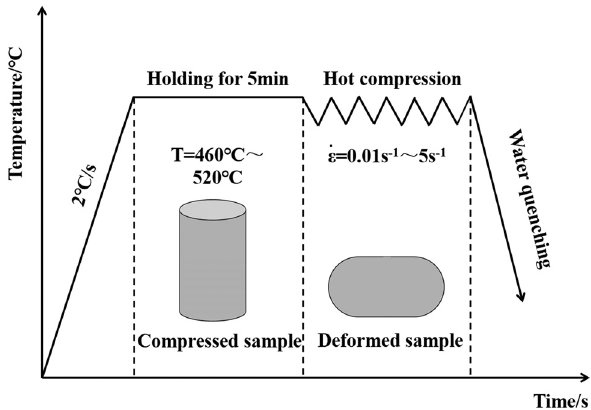
Figure 3: Schematic diagram of the hot compression